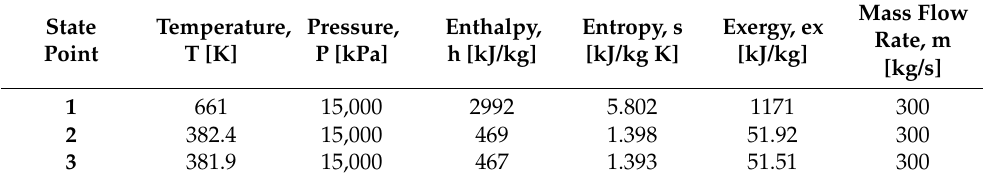
Table 1. State point values of Temperature, Pressure, Enthalpy, Entropy, Exergy and Mass flow rate of Geothermal